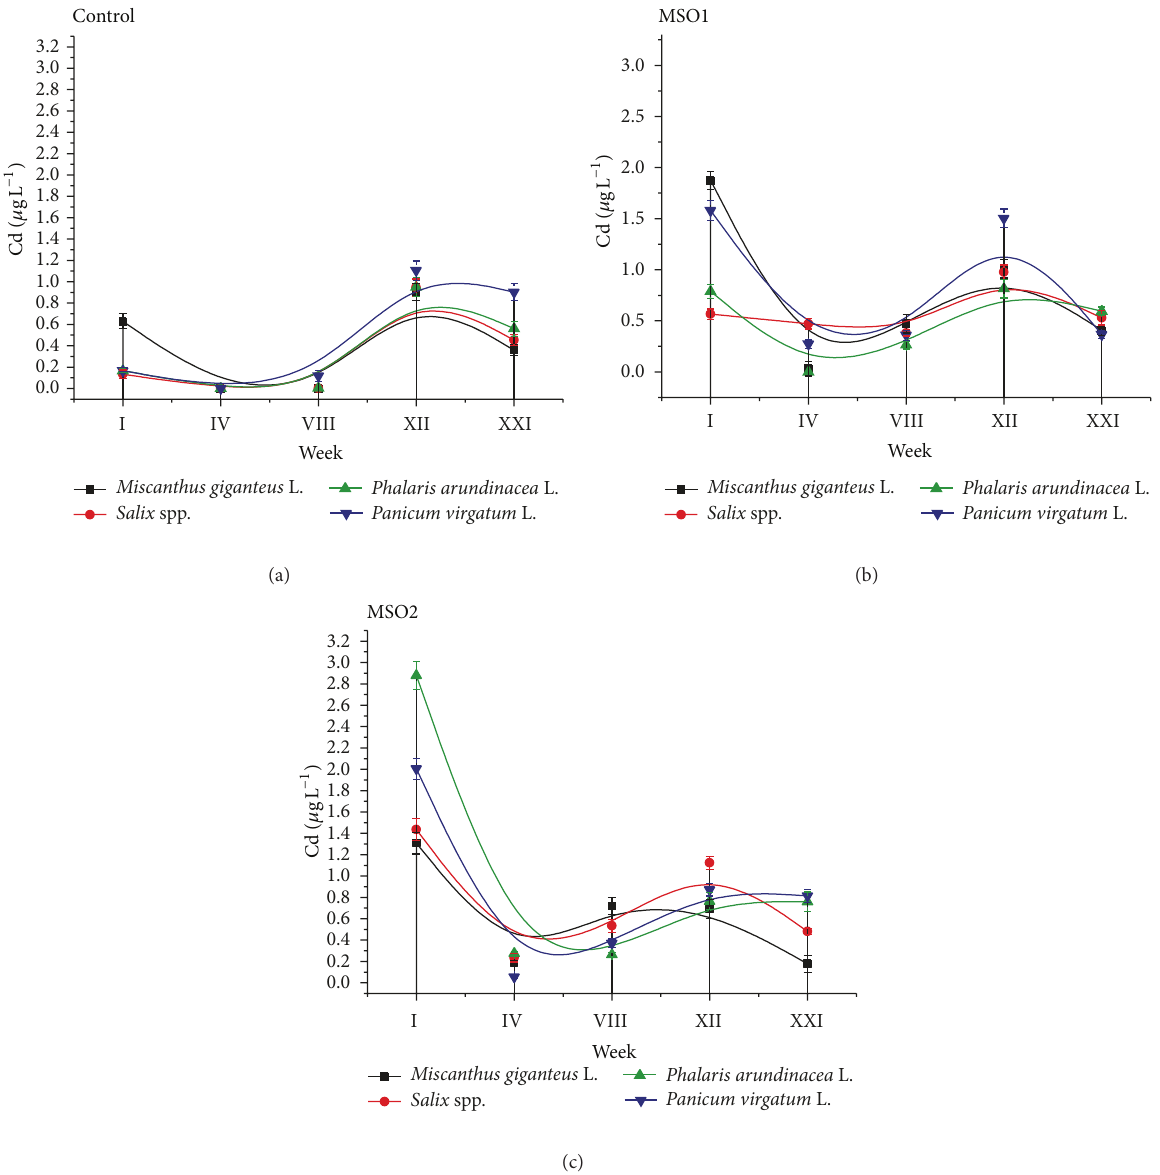
Figure 1: The content of Cd ions in soil leachate after the application of Trichoderma -based materials (MSO1 and